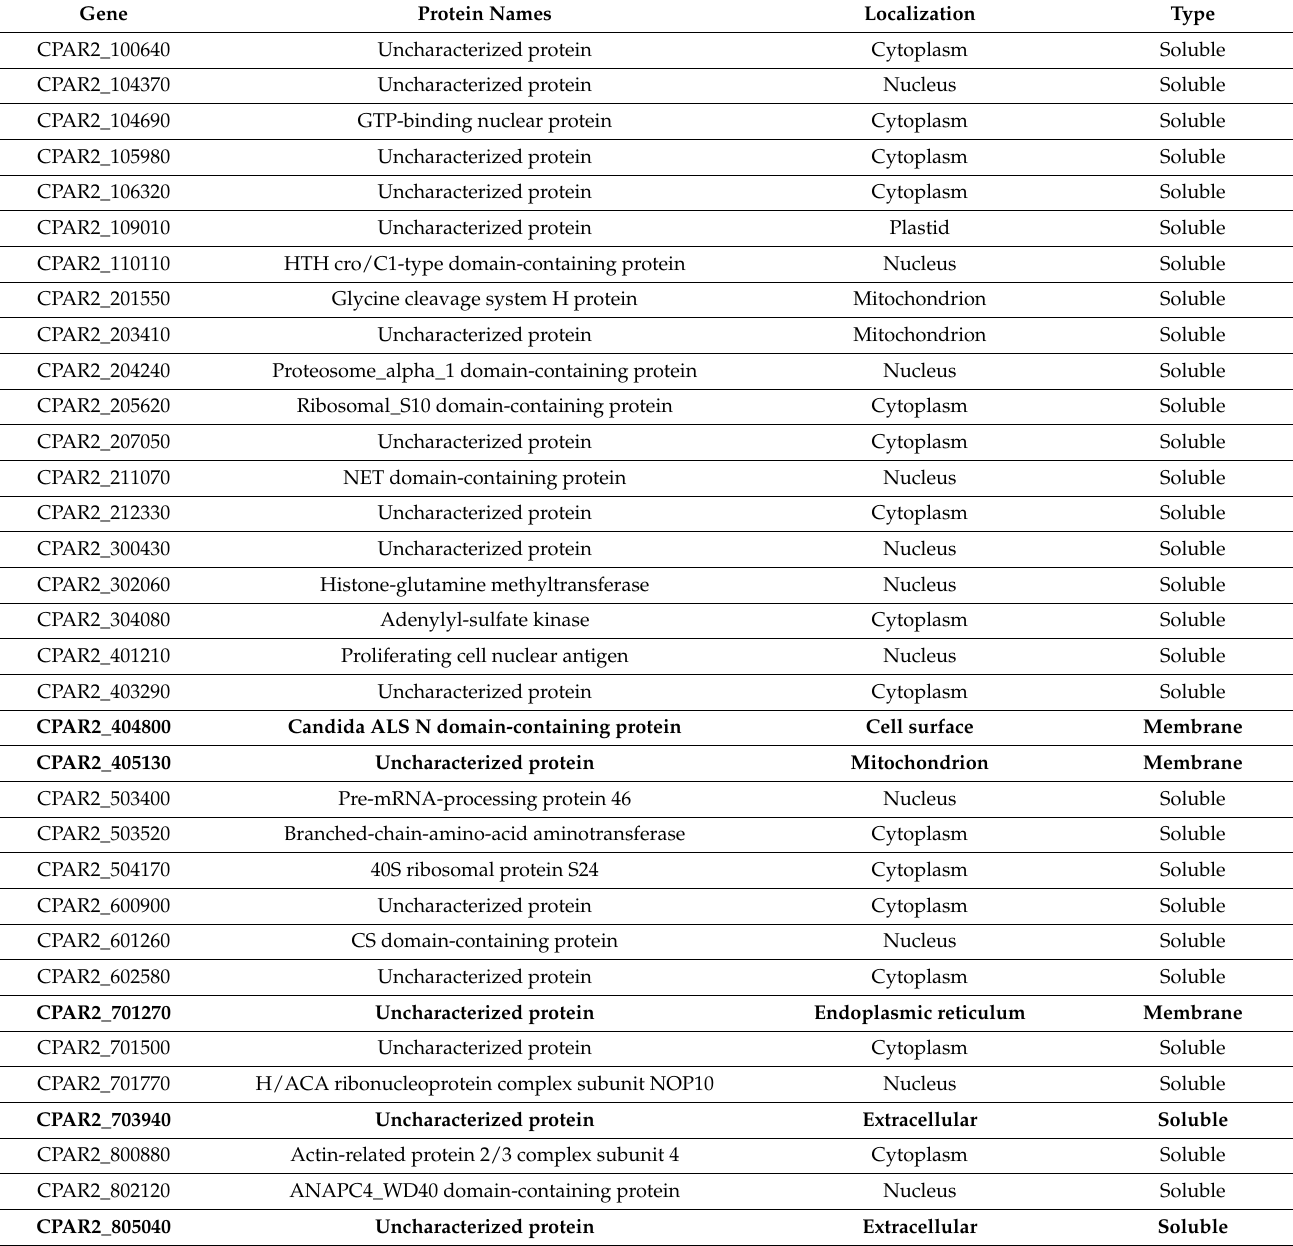
Table 2. List of predicted antigenic proteins that are present in the cell wall extract of C. parapsilosis .